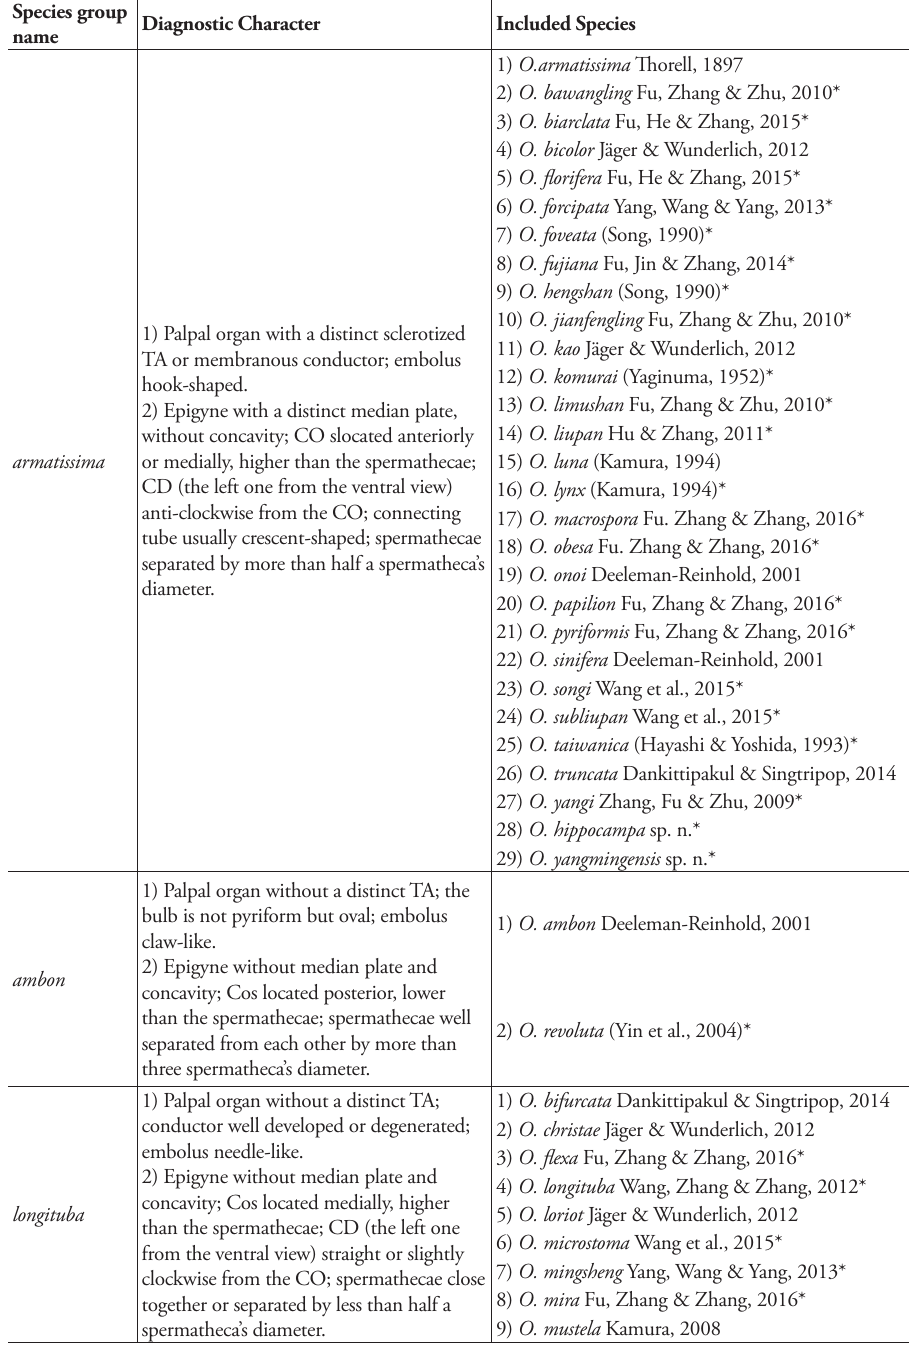
Table 1. Definition of species groups of Otacilia species, together with lists of included species (species marked with an asterisk are reported from